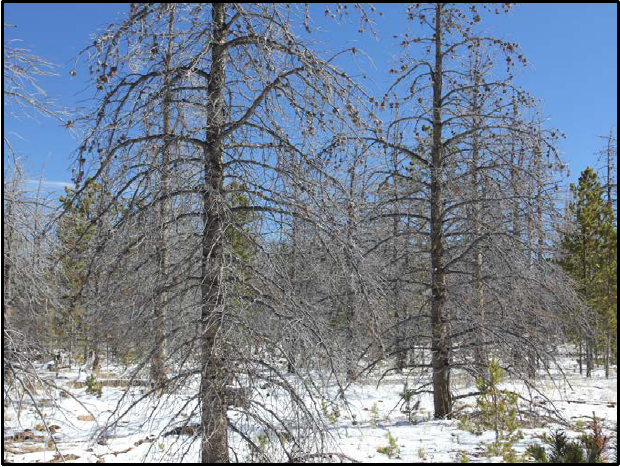
Figure 3. This lodgepole pine stand on the Uintah National Forest in Utah had a fairly small to average diameter and low relative density. While otherwise resistant to mountain pine beetle attack, it was nevertheless overwhelmed by a landscape-scale outbreak.